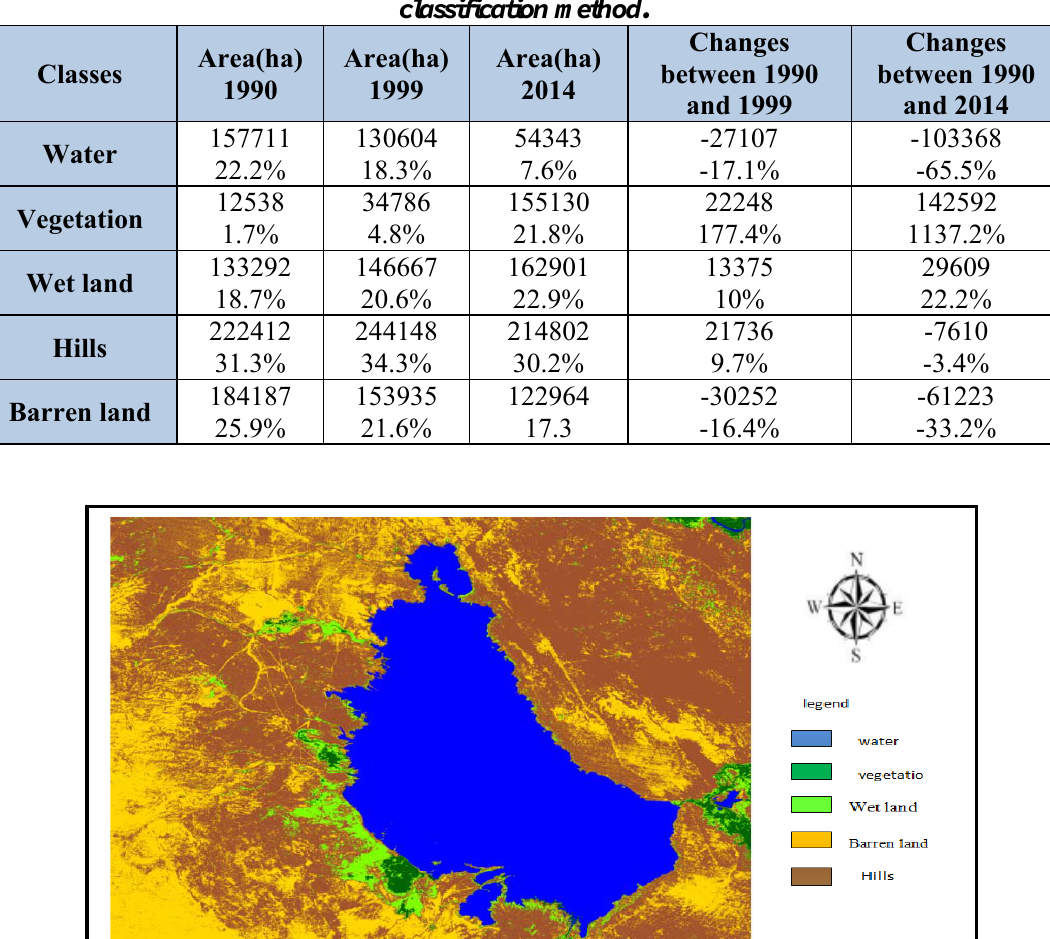
Fig.14: Supervised classification using Maximum Likelihood classifier method for